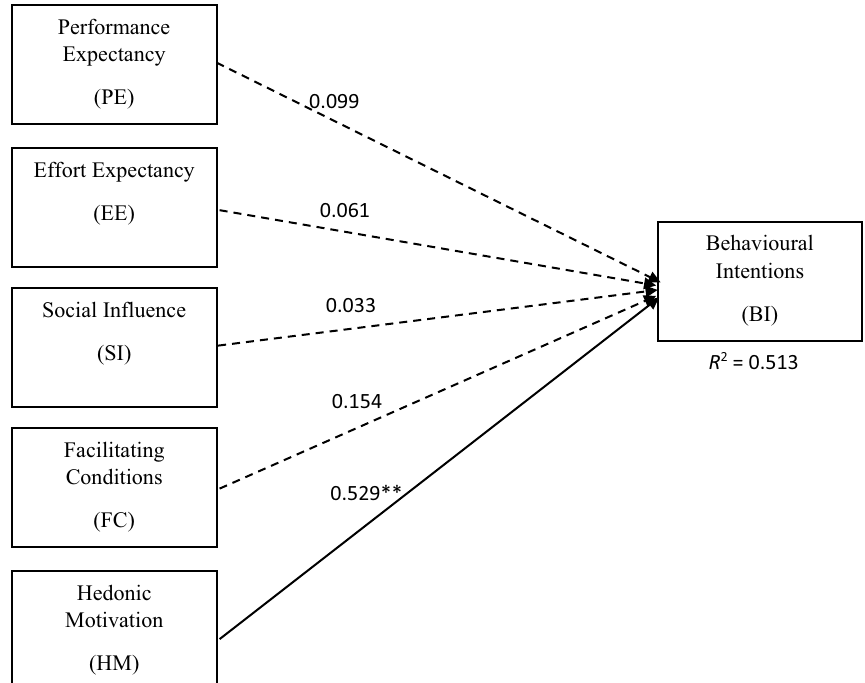
Fig. 3 Structural equation model to predict factors that influence intentions of engineering students to use digital games for engineering education (** p <